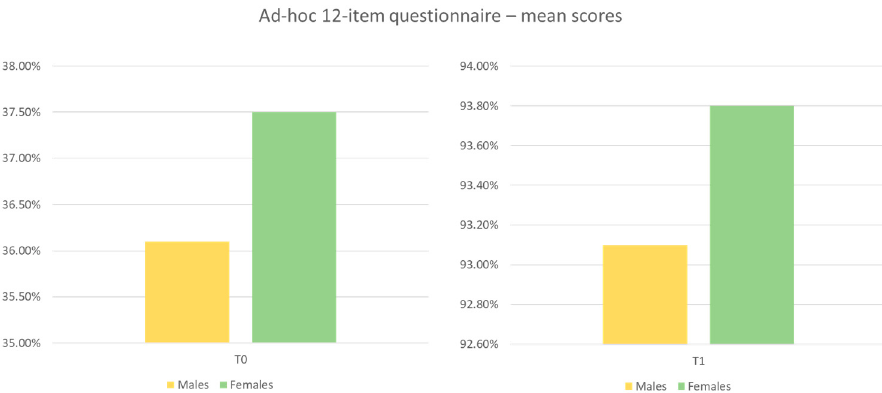
Figure 7. Comparison of average percentage scores obtained by males and females on the 12-item questionnaire.